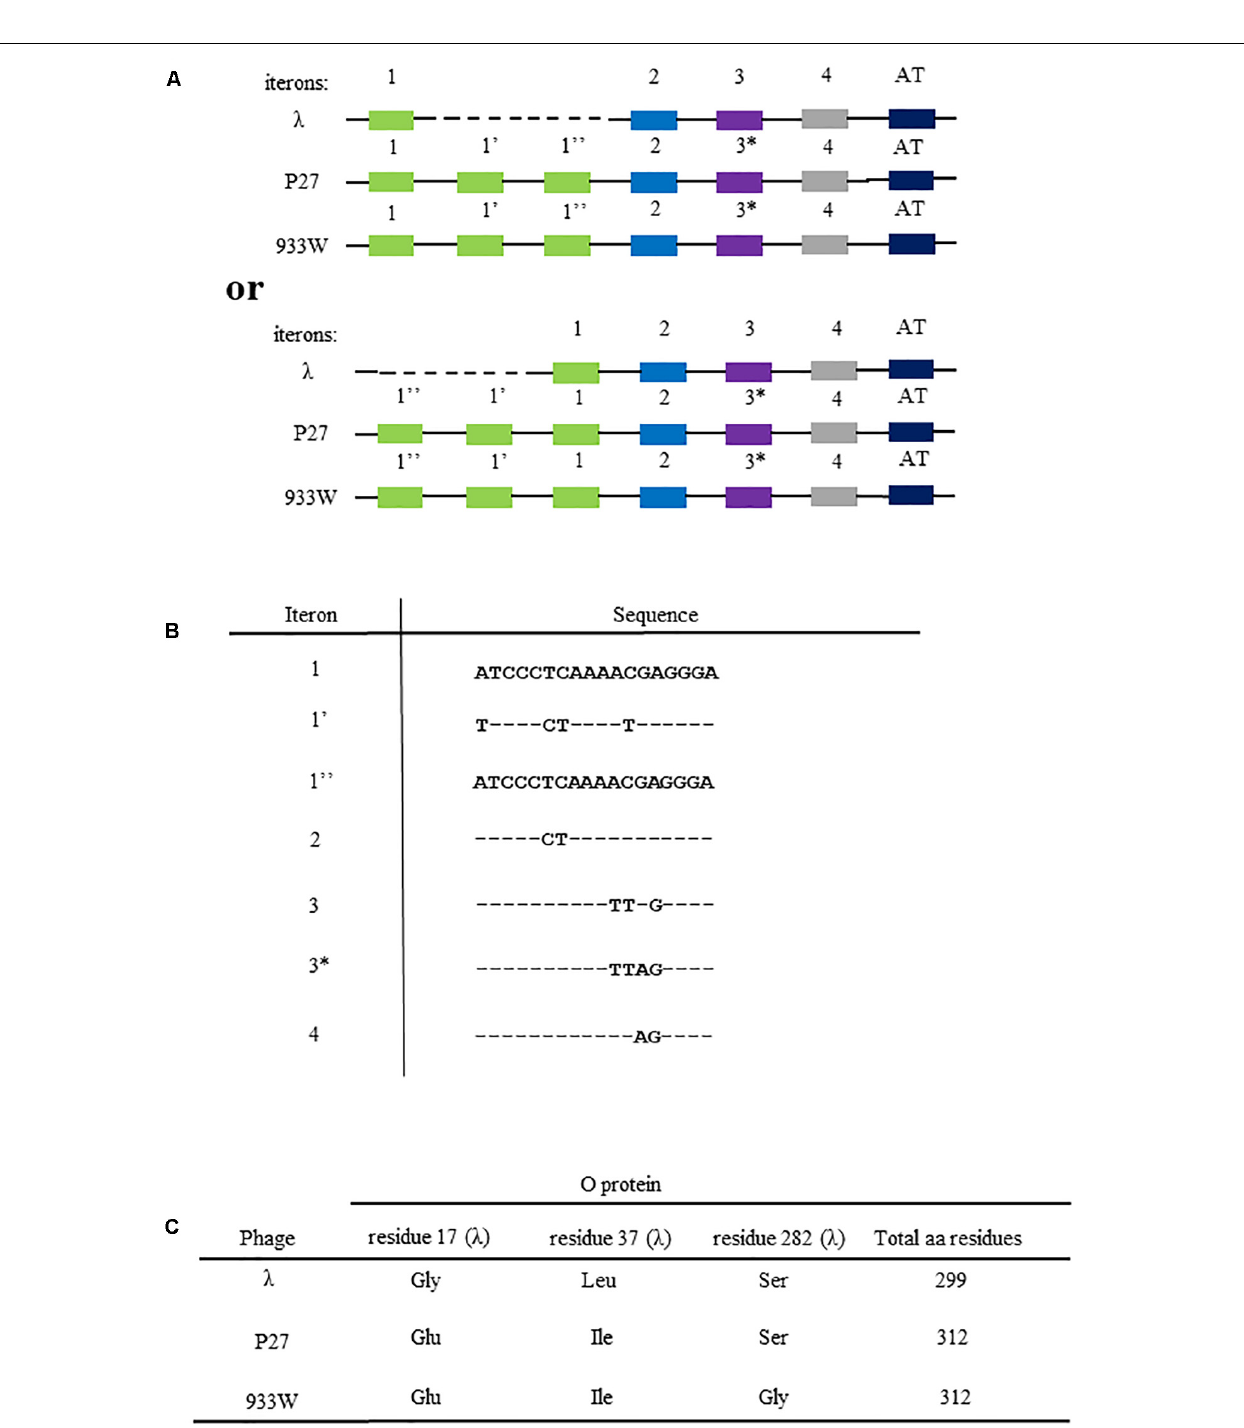
FIGURE 1 | Differences in the nucleotide sequences of viral genome fragments that are involved in the initiation of DNA replication of bacteriophage λ and Stx phages (P27 and 933). Compositions of iterons and the AT-rich fragment are shown in (A) (since sequences of iterons 1 and 1 (cid:48)(cid:48) are identical, two alternative ways of comparison between λ and Stx origin regions are possible, with dashed line indicating the missing fragment; the upper scheme presents the comparison as originally proposed by Nejman et al. (2009), and the lower scheme presents the alternative option). The scheme is not drawn to scale. Nucleotide sequences of iterons are shown in (B) , with ( − ) indicating bases identical to those occurring in iteron 1 and 1 (cid:48)(cid:48) , and letters indicating substitutions. Differences in amino acid sequences of O proteins of bacteriophage λ and Stx phages (P27 and 933W) are depicted in (C)